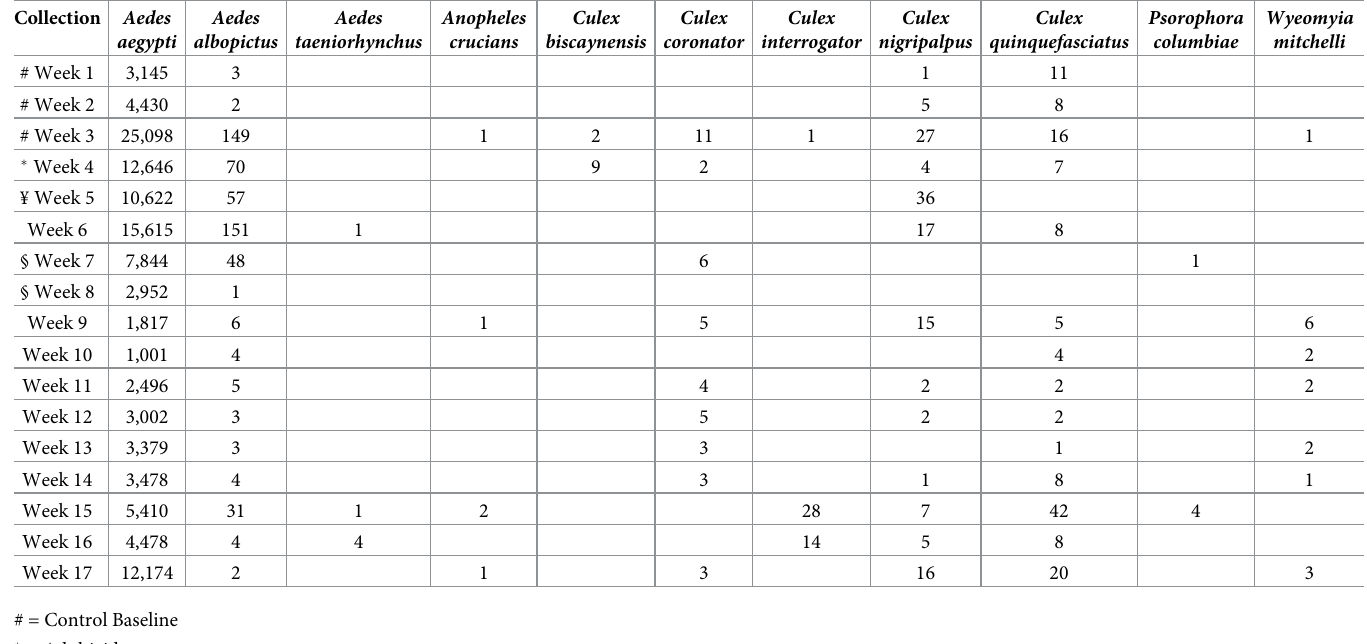
Table 1. Effect of insecticide intervention in the abundance of adult mosquitoes at the study area in Miami-Dade County, Florida, from June 7th to September 27th, 2018. Collection Aedes